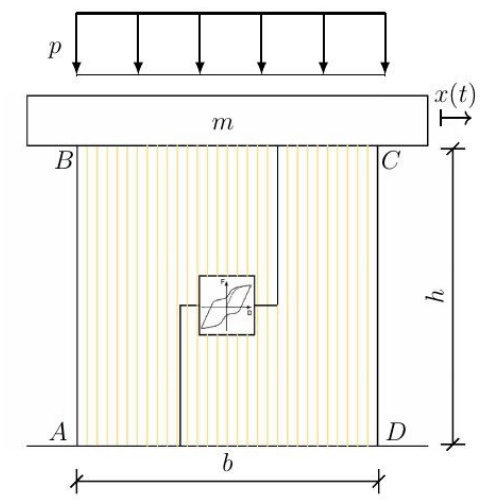
Figure 1. SDOF Idealization of a CLT wall panel through a SDOF Mechanical